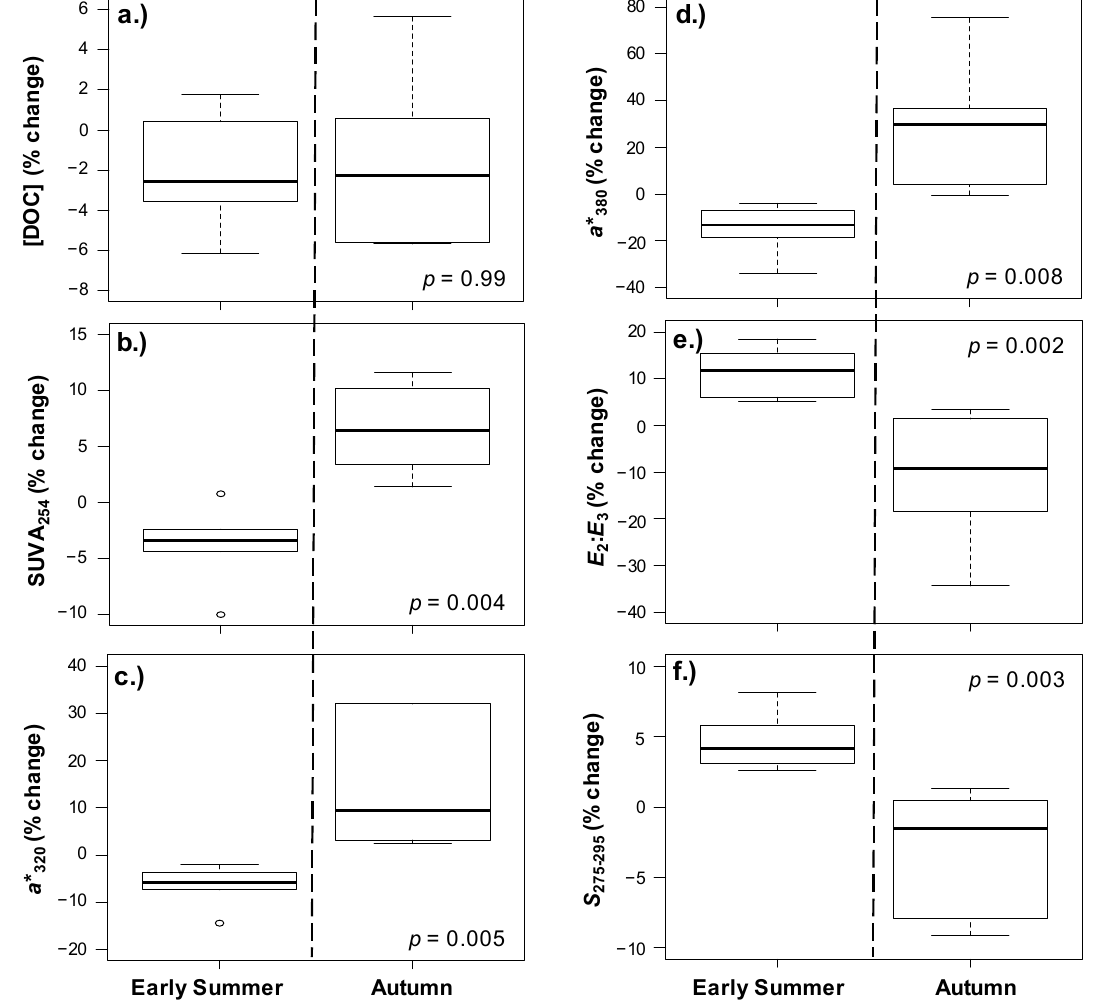
Figure 3. Responses of the six study lakes for ( a ) [DOC], ( b ) SUVA 254 , ( c ) a * 320 , ( d ) a * 380 , ( e ) E 2 : E 3 , and ( f ) S 275–295 of Early Summer versus Autumn storms represented by percent change from Pre to P2 ( n = 6). The p values indicate differences between Early Summer and Autumn.